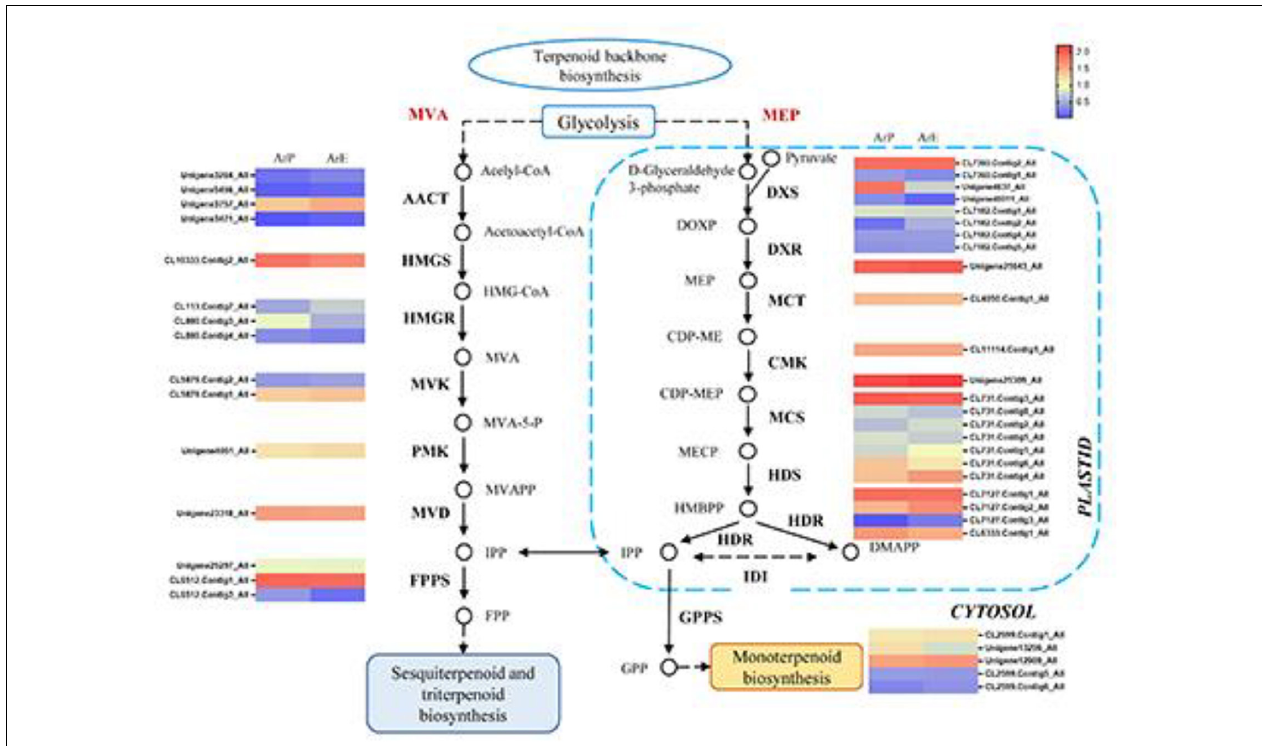
FIGURE 3 | Schematic overview of the MVA and MEP pathway in A. rugosa and heatmap of the corresponding enzymes involved in the pathway. The main enzymes are shown with the abbreviation throughout respective enzymatic steps. Enzyme abbreviations are AACT: acelyl-CoA C-acetyltransferase; HMGC, hydroxymethylglutaryl-CoA synthase; HMGR, hydroxymethylglutaryl-CoA reductase; MVK, mevalonate kinase; PMK, phosphomevalonate kinase; MVD, diphosphomevalonate decarboxylase; FPPS, farnesyl pyrophosphate synthase; DXS, 1-deoxy-D-xylulose-5-phosphate synthase; DXR, 1-deoxy-D-xylulose-5-phosphate reductase; MCT, 2-C-methyl-D-erythritol 4-phosphate cytidylyltransferase; CMK, 4-diphosphocytidyl-2-C-methyl-D-erythritol kinase; MCS, 2-C-methyl-D-erythritol 2,4-cyclodiphosphate synthase; HDS, (E)-4-hydroxy-3-methylbut-2-enyl-diphosphate synthase; HDR, 4-hydroxy-3-methylbut-2-en-1-yl diphosphate reductase; IDI, isopentenyl-diphosphate Delta-isomerase; GPPS, geranyl diphosphate synthase.